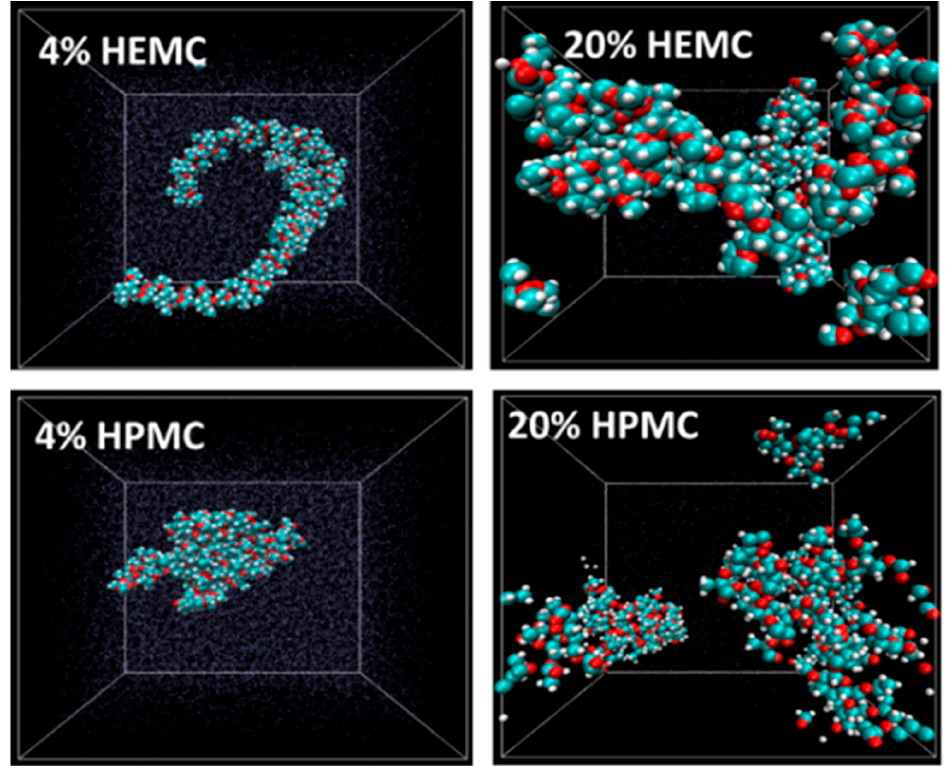
Figure 12. Conformation of HEMC and HPMC at 4 mass % and 20 mass %; O-red, C-blue and H-white. Box size is square and constant at 4.2 nm (42 Å).